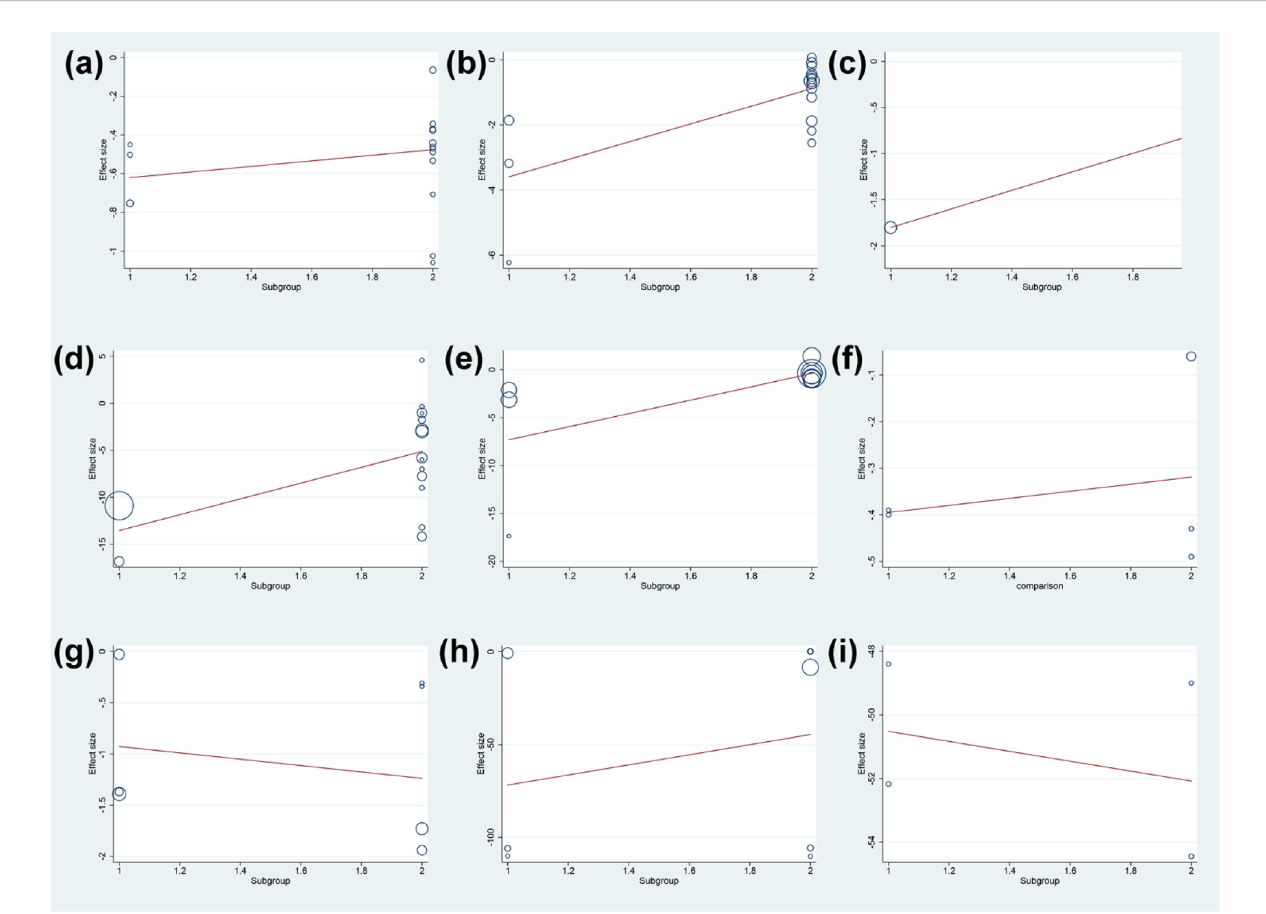
FIGURE 16 Meta-regression Results of dose (A) adverse events of total glucosides of paeony; (B) CRP of total glucosides of paeony; (C) DAS28 of total glucosides of paeony; (D) ESR of total glucosides of paeony; (E) RF of total glucosides of paeony; (F) CRP of curcumin; (G) DAS28 of curcumin; (H) ESR of curcumin; (I) RF of